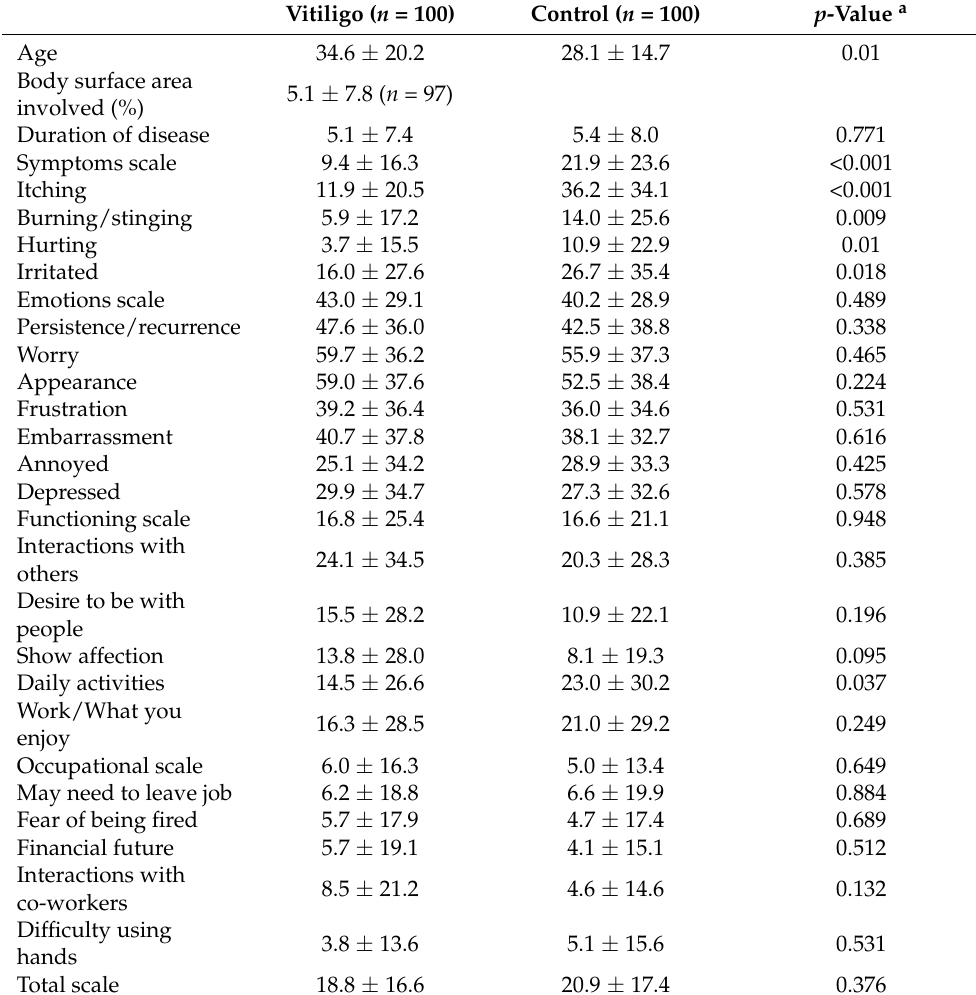
Table 1. The modified Skindex-21 questionnaire survey results for patients with